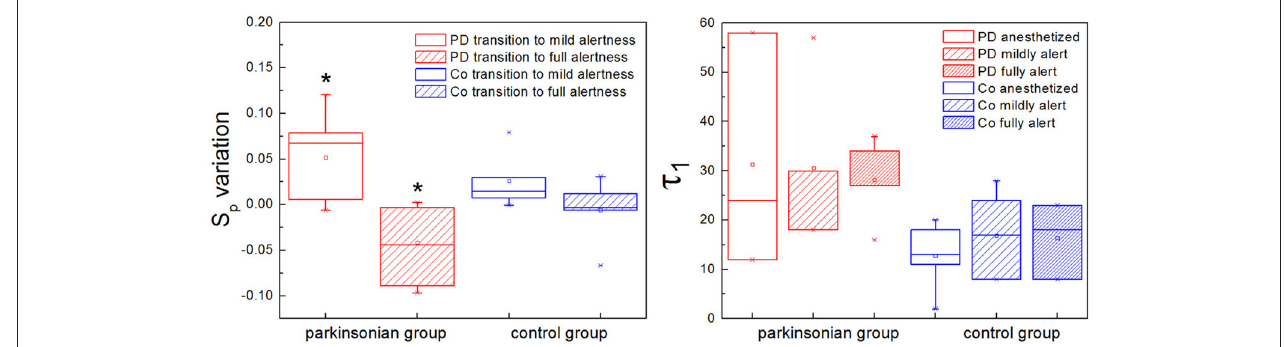
FIGURE 5 | The plateau height ( S p ) and the inflection point ( τ 1 ) characterize the structure function if nonlinearity is present. (Left) The plateau height S p can be used to compare the activity of the same neuron at different time points, assuming that recording conditions do not change. In the parkinsonian group, S p varies significantly more between anesthesia and mild alertness than between mild and full alertness (* p < 0.01). This is new evidence showing that in Parkinson’s disease (PD) basal ganglia neurons are unable to handle the awakening process well. This effect is not observed in the control group of animals (Co). (Right) The inflection point τ 1 is higher in the parkinsonian group for all alertness levels, with a more pronounced effect as alertness increases. These results are not statistically significant ( p > 0.05), and need to be confirmed with larger experimental